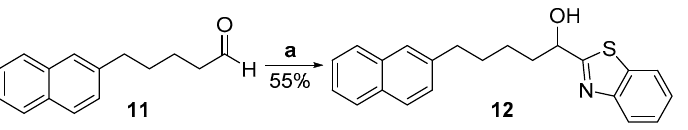
Figure 5. Synthesis of compound 12 . (a) Benzothiazole, n -BuLi, dry Et 2 O, − 78 °C to rt.